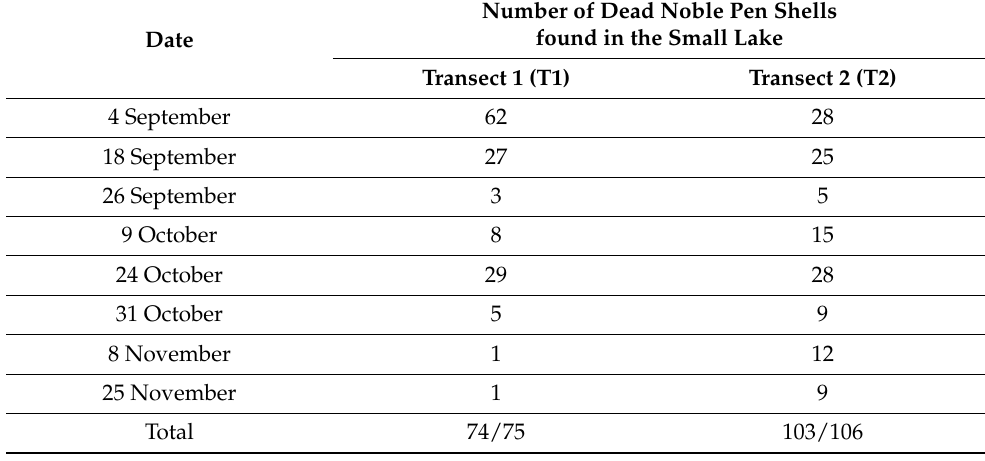
Table 2. Number of dead noble pen shells found along the transects from the setup of the pilot study (4 September 2019) until its completion (25 November